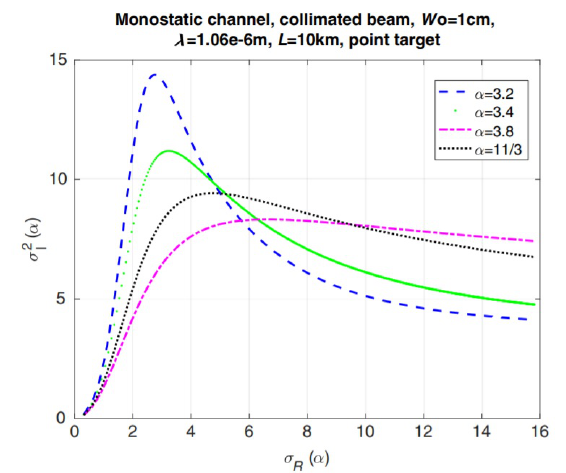
Figure 21. Mono-static case: scintillation index as a function of the square root of the Rytov variance for several power law values. Reprinted with permission from Reference [104].